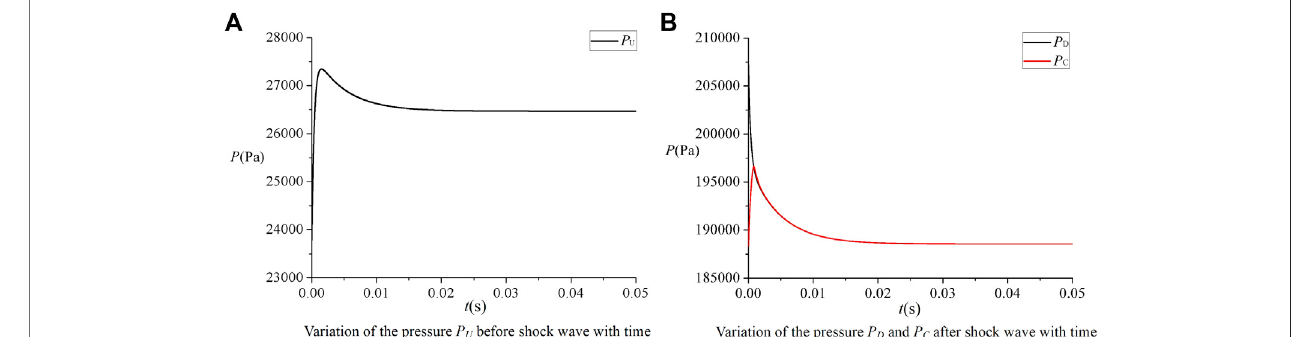
FIGURE 6 | Pressure change process.